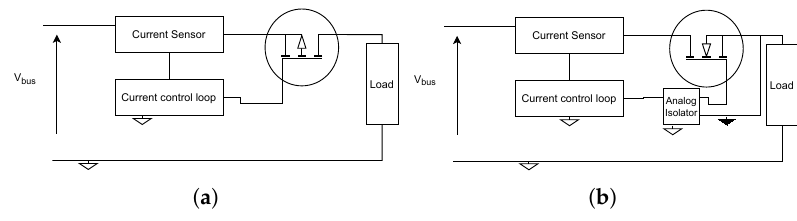
Figure 2. Latching Current Limiters: ( a ) P Channel based; ( b ) N Channel based.